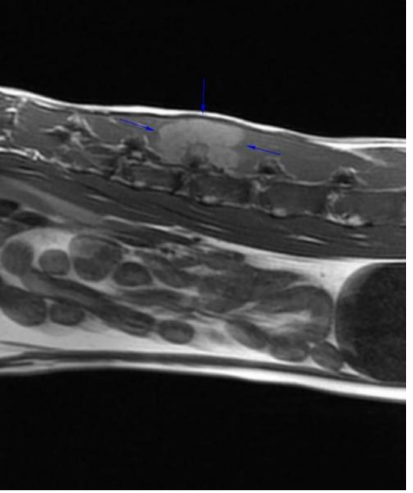
Figure 1. Right para-sagittal pre-contrast T1W image of the mass showing the T1W hyperintense mass in the right epaxial muscle dorsal to L2 and L3 (blue arrows).